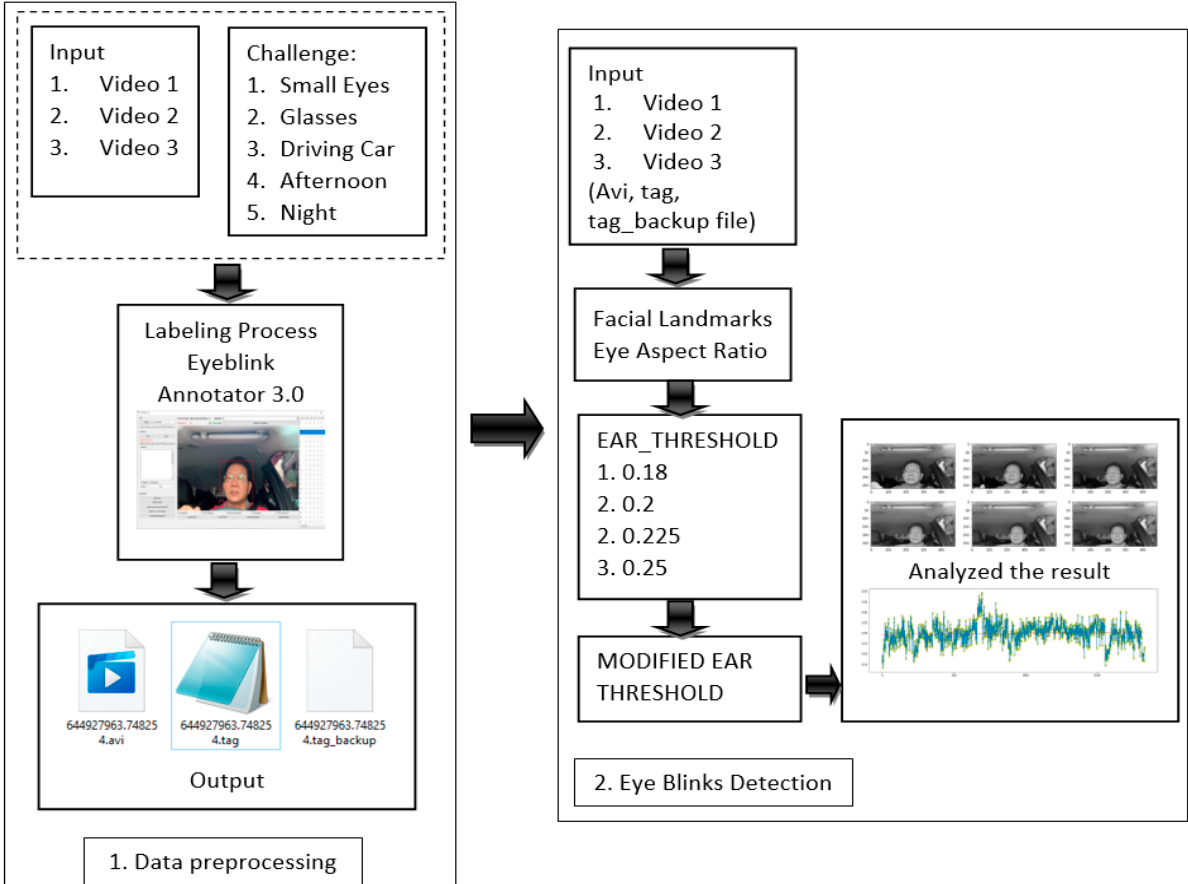
Figure 3. The system architecture. Figure 4. The system Table 1. Video dataset information.